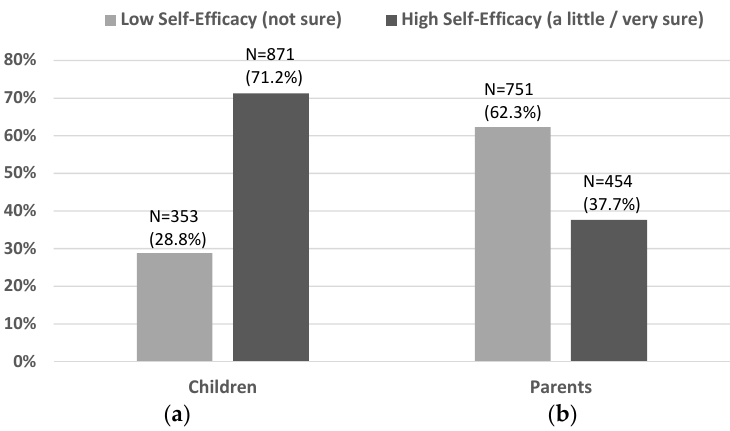
Figure 2. Low vs. High Self-Efficacy among Children and Parents: ( a ) Child Self-Efficacy; and, ( b ) Parent Self-Efficacy.